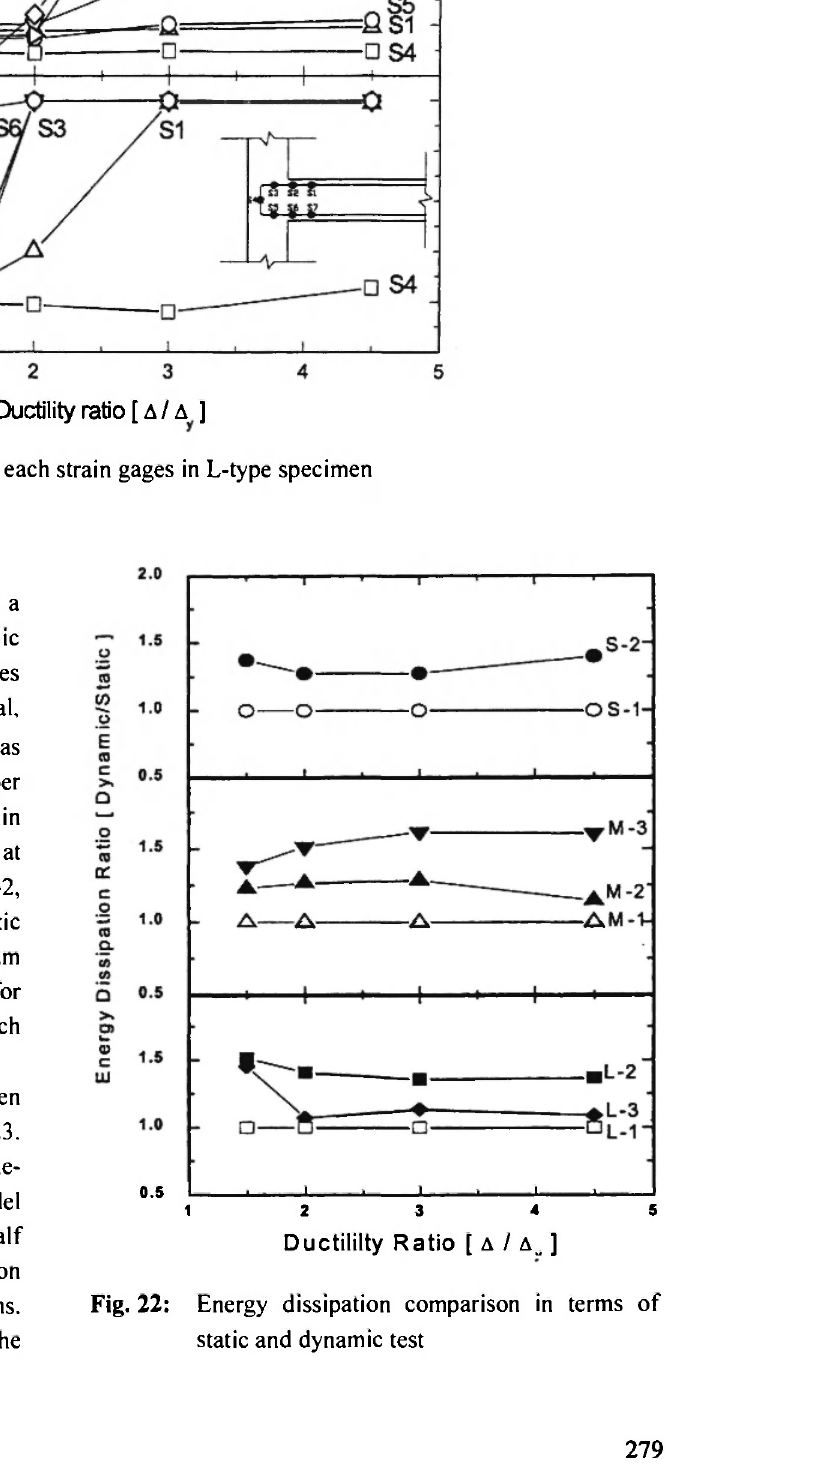
Fig. 21: Deformation of each strain gages in L-type specimen